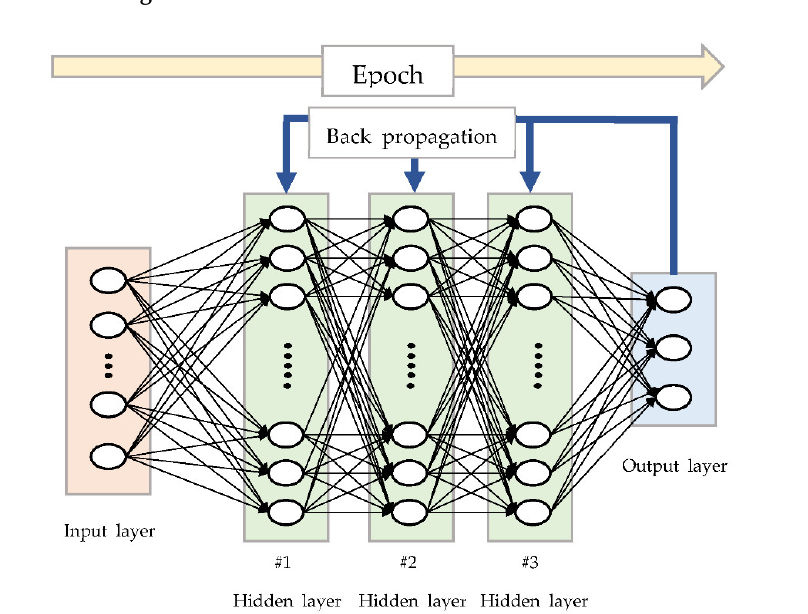
Figure 9. Schematic of deep neural network.